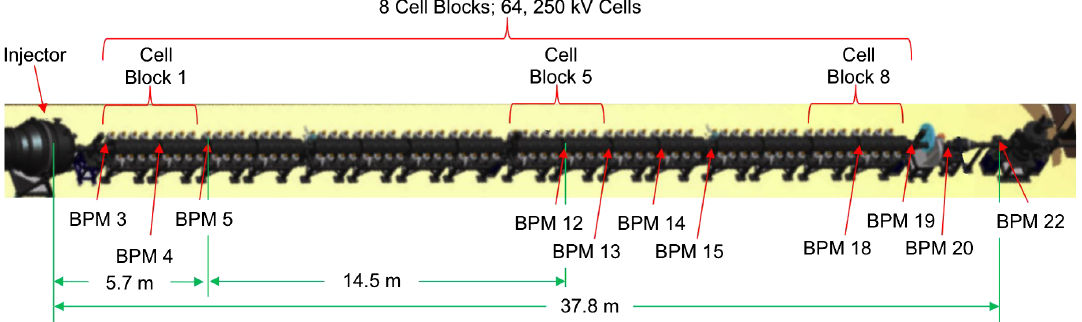
FIG. 1. Model of the DARHT Axis-1 accelerator, consisting of the 4 MV injector, 64 induction cells, and a BPM located after every 4